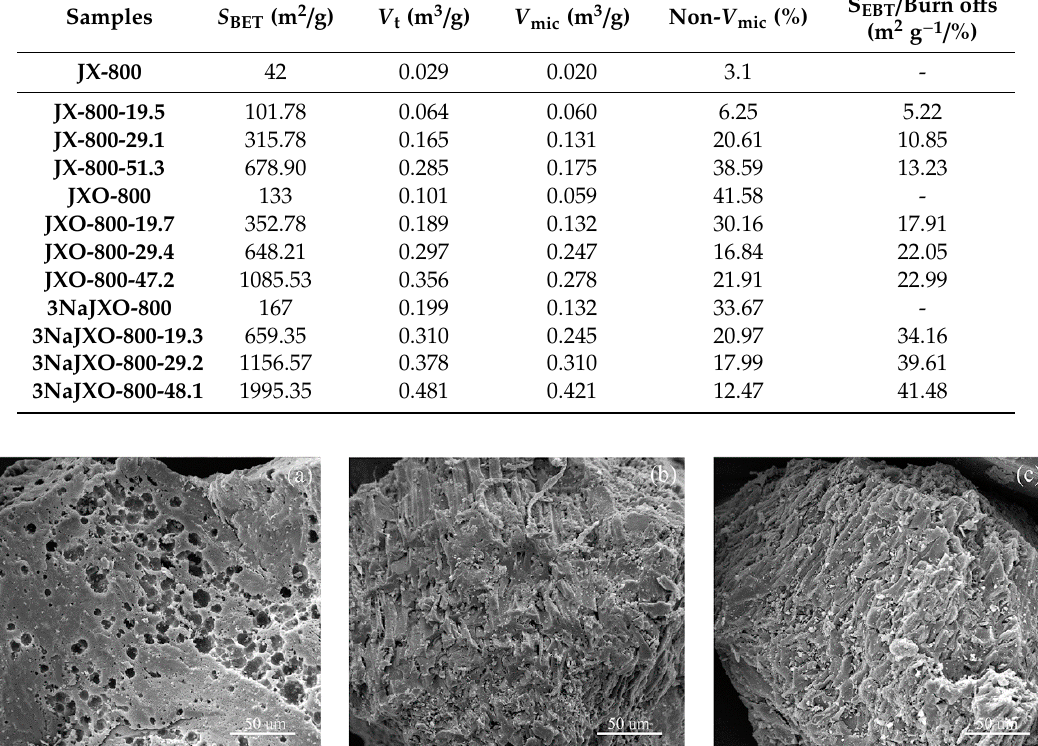
Figure 5. SEM images of typical chars under final burn ‐ off values ( a ) JX ‐ 800 ‐ 51.3; ( b ) JXO ‐ 800 ‐ 47.2; ( c ) 3NaJXO ‐ 800 ‐ 48.1.